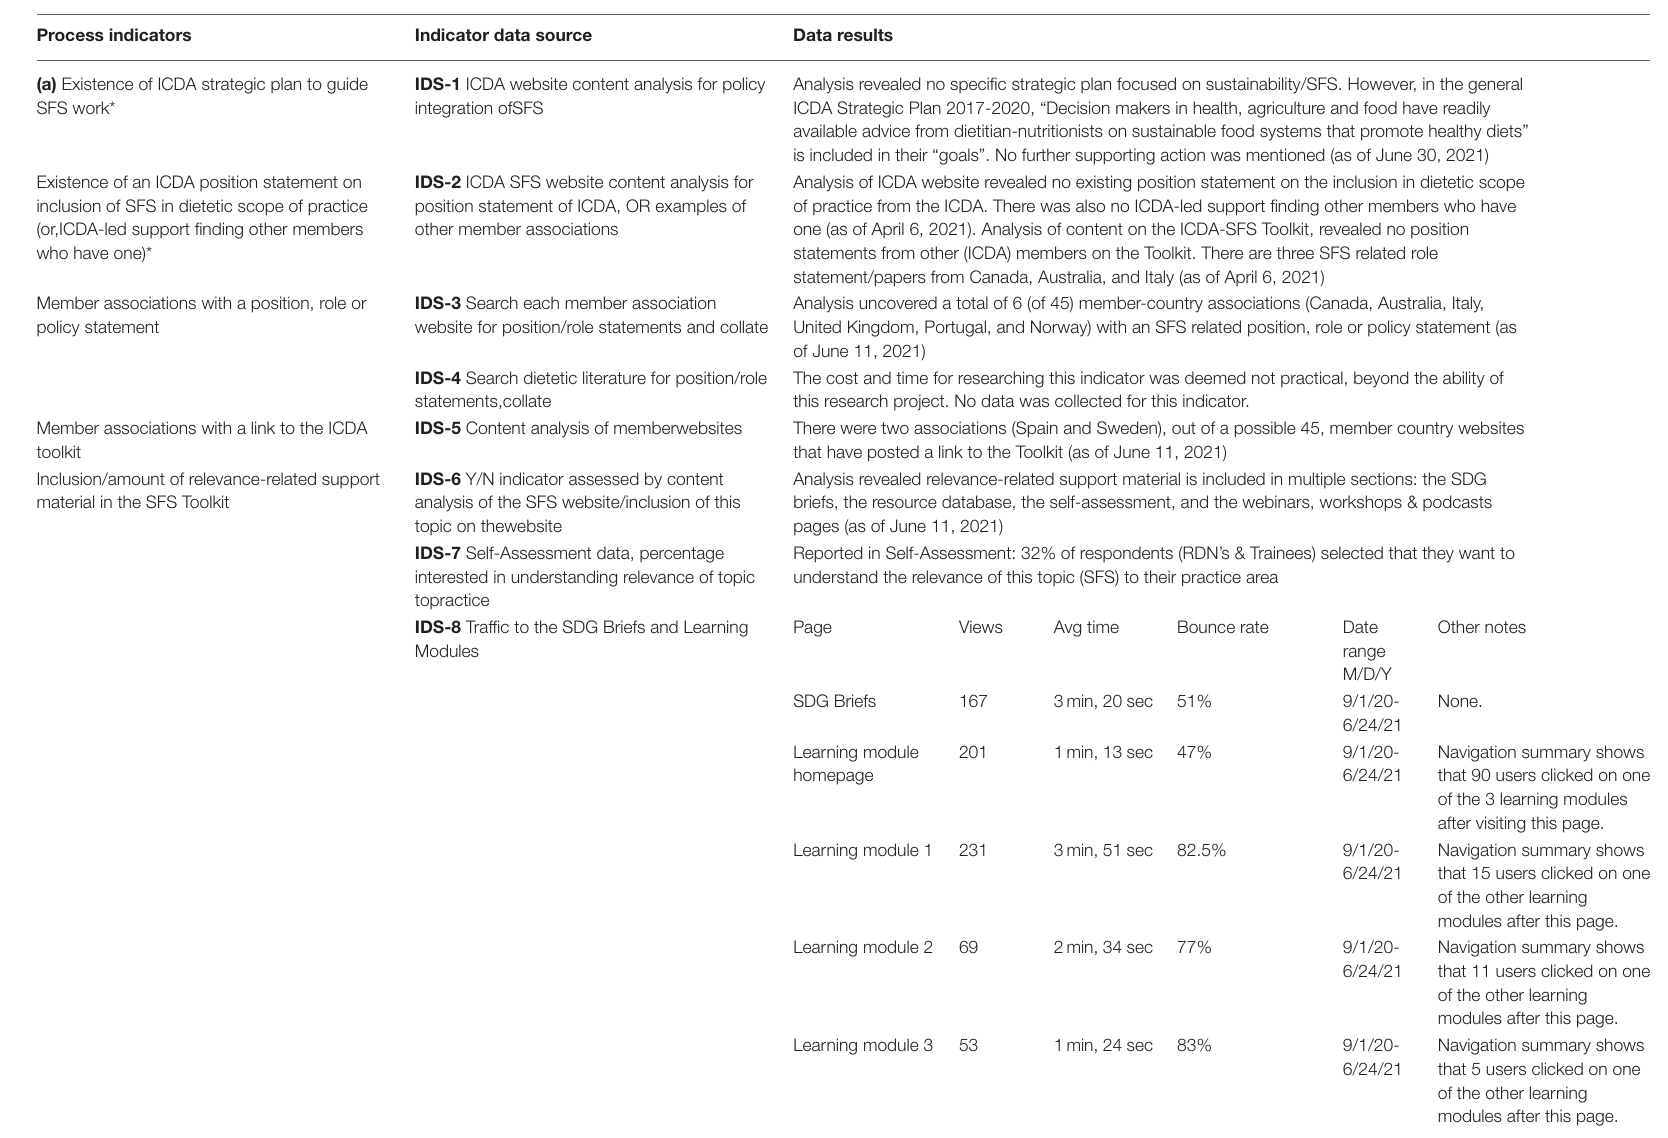
TABLE 3 | (a) Barrier 1 – Inability to influence peers on relevance of SFS to practice; (b) Barrier 2 – Cultural norms in the workplace impede RDN SFS work; (c) Barrier 3 – Lack of a clear, collective vision of success; (d) Barrier 4 – Complexity of food systems issues is overwhelming; (e) Barrier 5 – Rapid emergence of new research and developments, difficult to keep up with; (f) Barrier 6 – Lack of common language